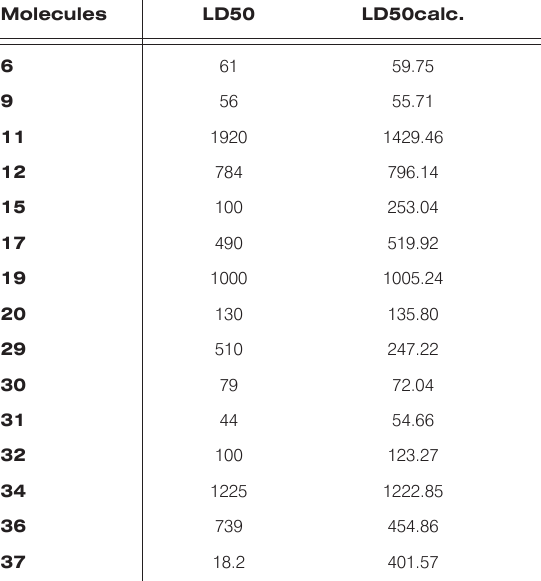
Table 10. Calculated values of LD50 by similarity clusters, for the molecules in the test set. Molecules